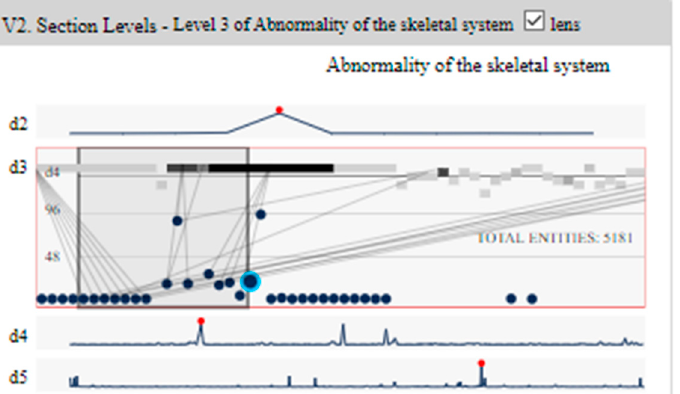
Figure 15. The magic lens within the Ontology Section Levels Panel. We have designed the magic lens with an interaction which generates lines to represent the set of ontology relations within the level as we drag horizontally across the visual space.